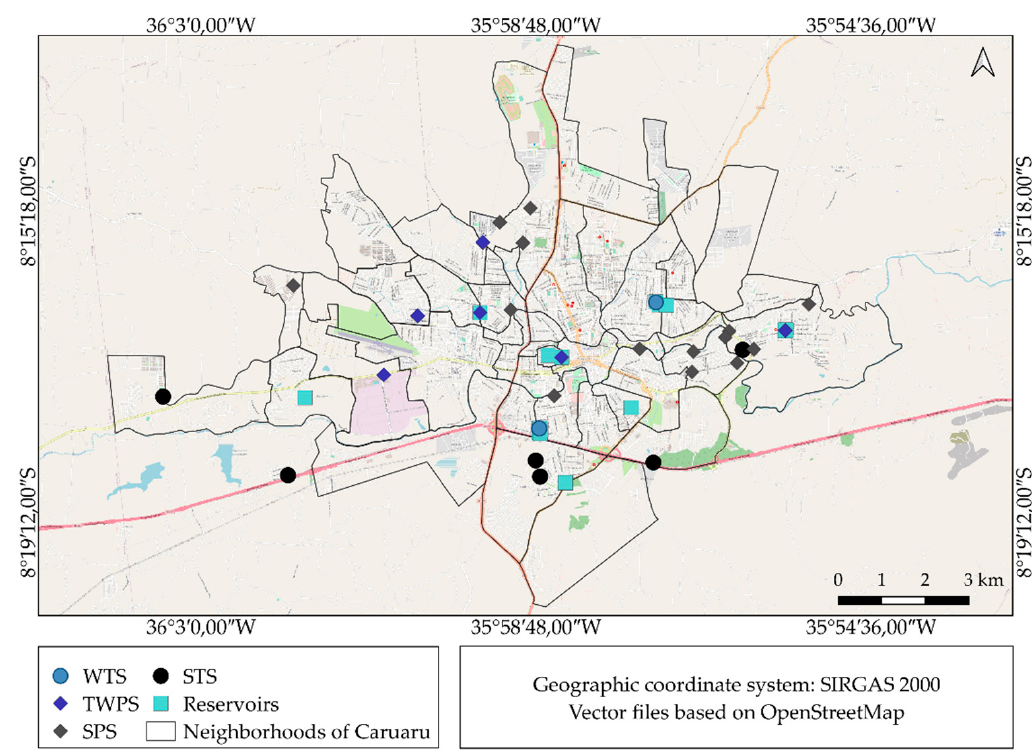
Figure 3. Components of the UWSS and the SSS of Caruaru.